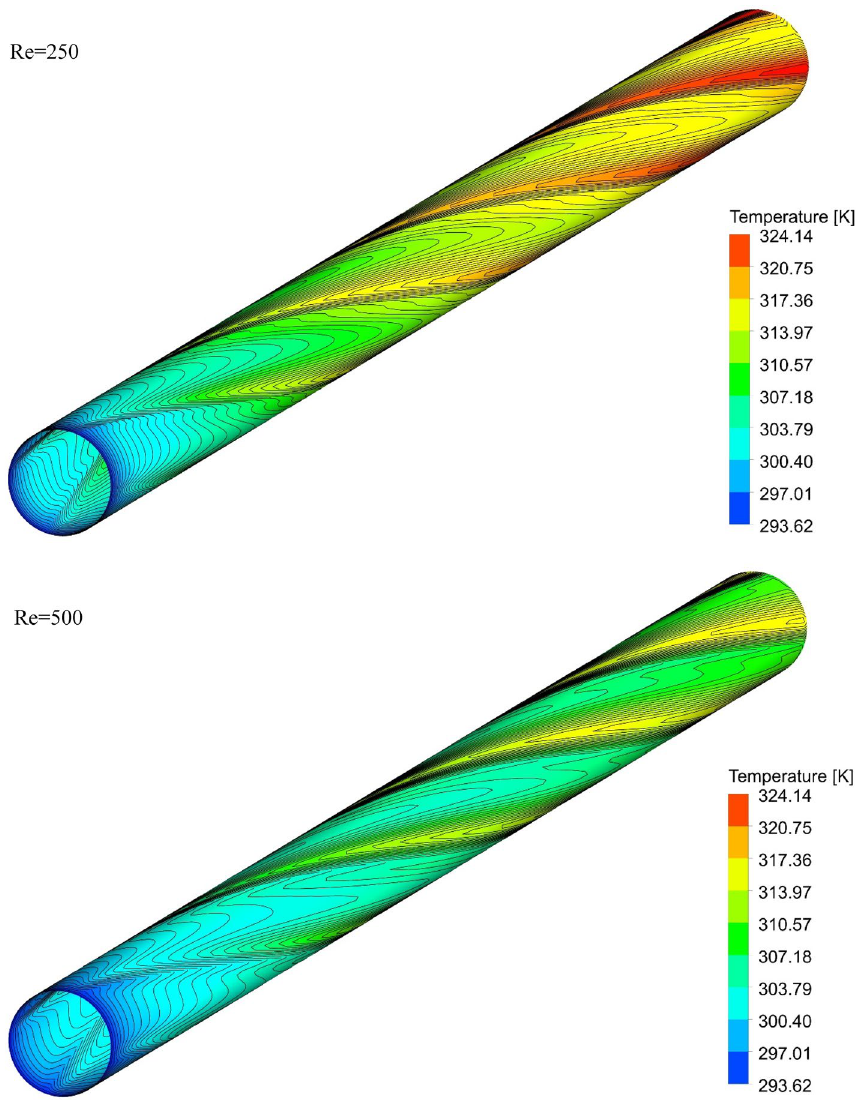
Figure 15. Isotherm contours on the surface of the pipe in φ = 0% and Case